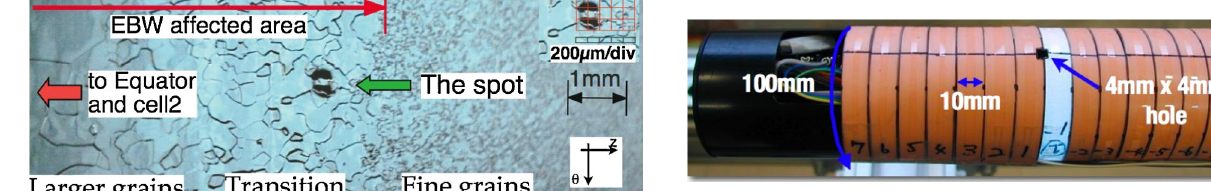
FIG. 8. (Color) Cat’s-eye spot found at the equator region of cell 3, 181 (cid:3) . The diameter is about 400 (cid:1) m .